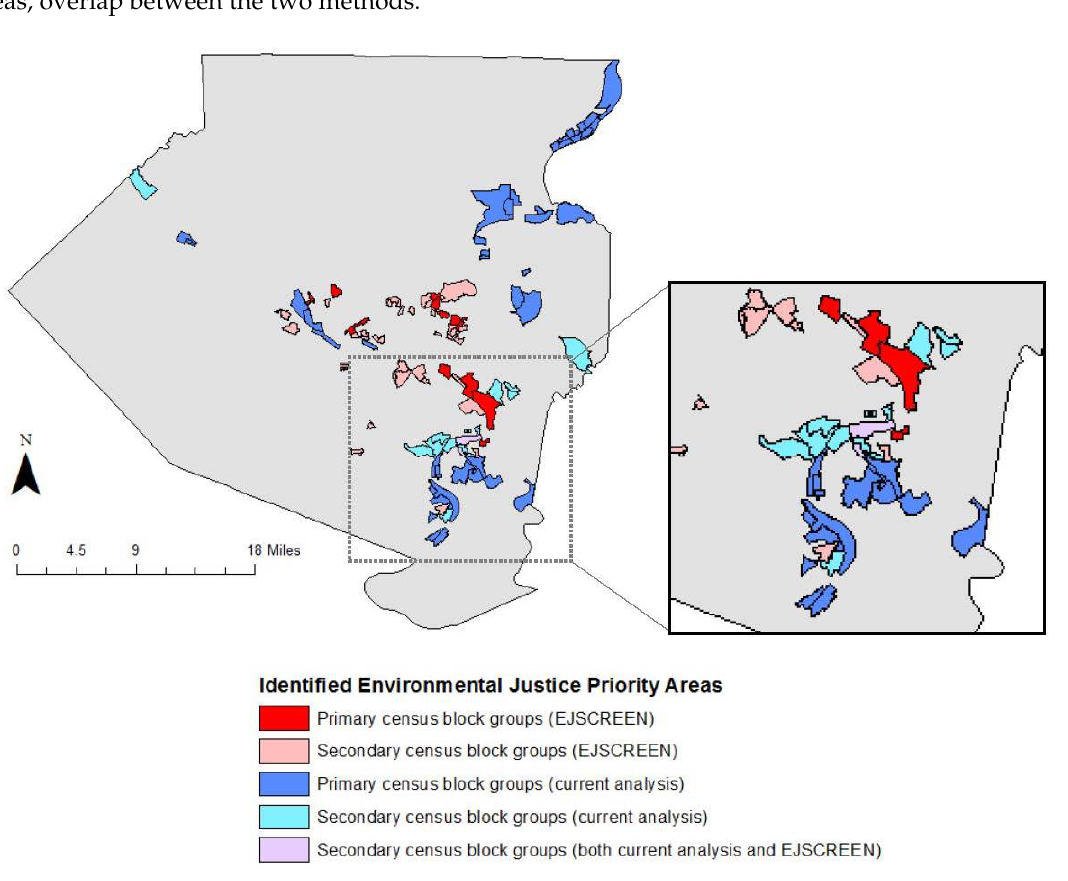
Figure 3. Environmental justice priority areas identified in Allegheny County, PA, by EJSCREEN and a newly developed environmental justice indicator that uses job accessibility as a parameter. Primary census block groups identified using EJSCREEN represent index values in the 95th percentile and above; secondary traditional priority areas are between the 90th and 95th percentile. Primary census block groups identified in the current analysis are those with PM 2.5 concentrations > 12 µg/m 3